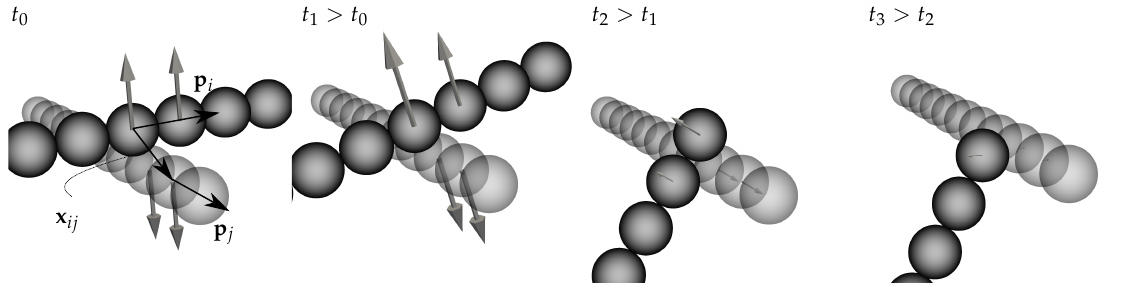
Figure 4. Snapshots of two fibers in contact. At contact initiation t 0 , p i and p j denote unit vectors for the fiber directions and x ij is the vector between particles of one active contact pair ( i , j ) . The contact forces are indicated by arrows which scale with contact force magnitude and rotate in the subsequent time steps ( t 1 , t 2 , t 3